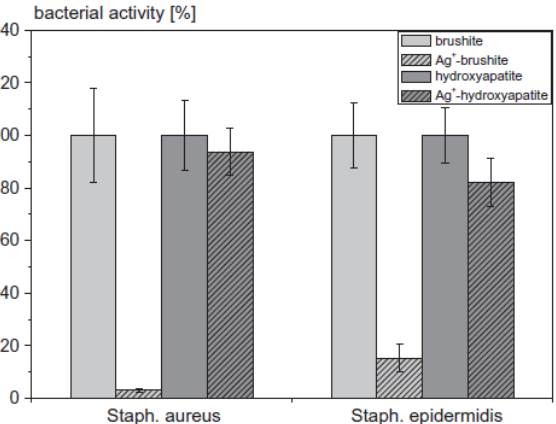
Figure 6. The bacterial activity of S. aureus and Staphylococcus epidermidis on cement surfaces (n = 4) determined by the WST-1-test in LB medium ( adapted with permission from reference [58]).